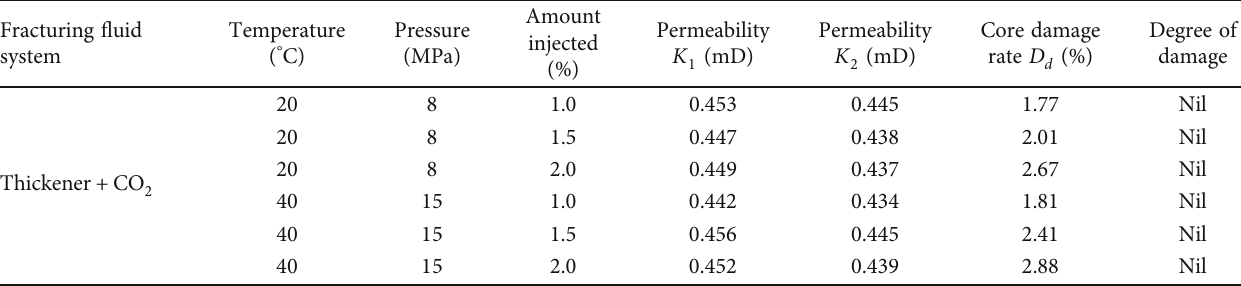
fracturing fl 2